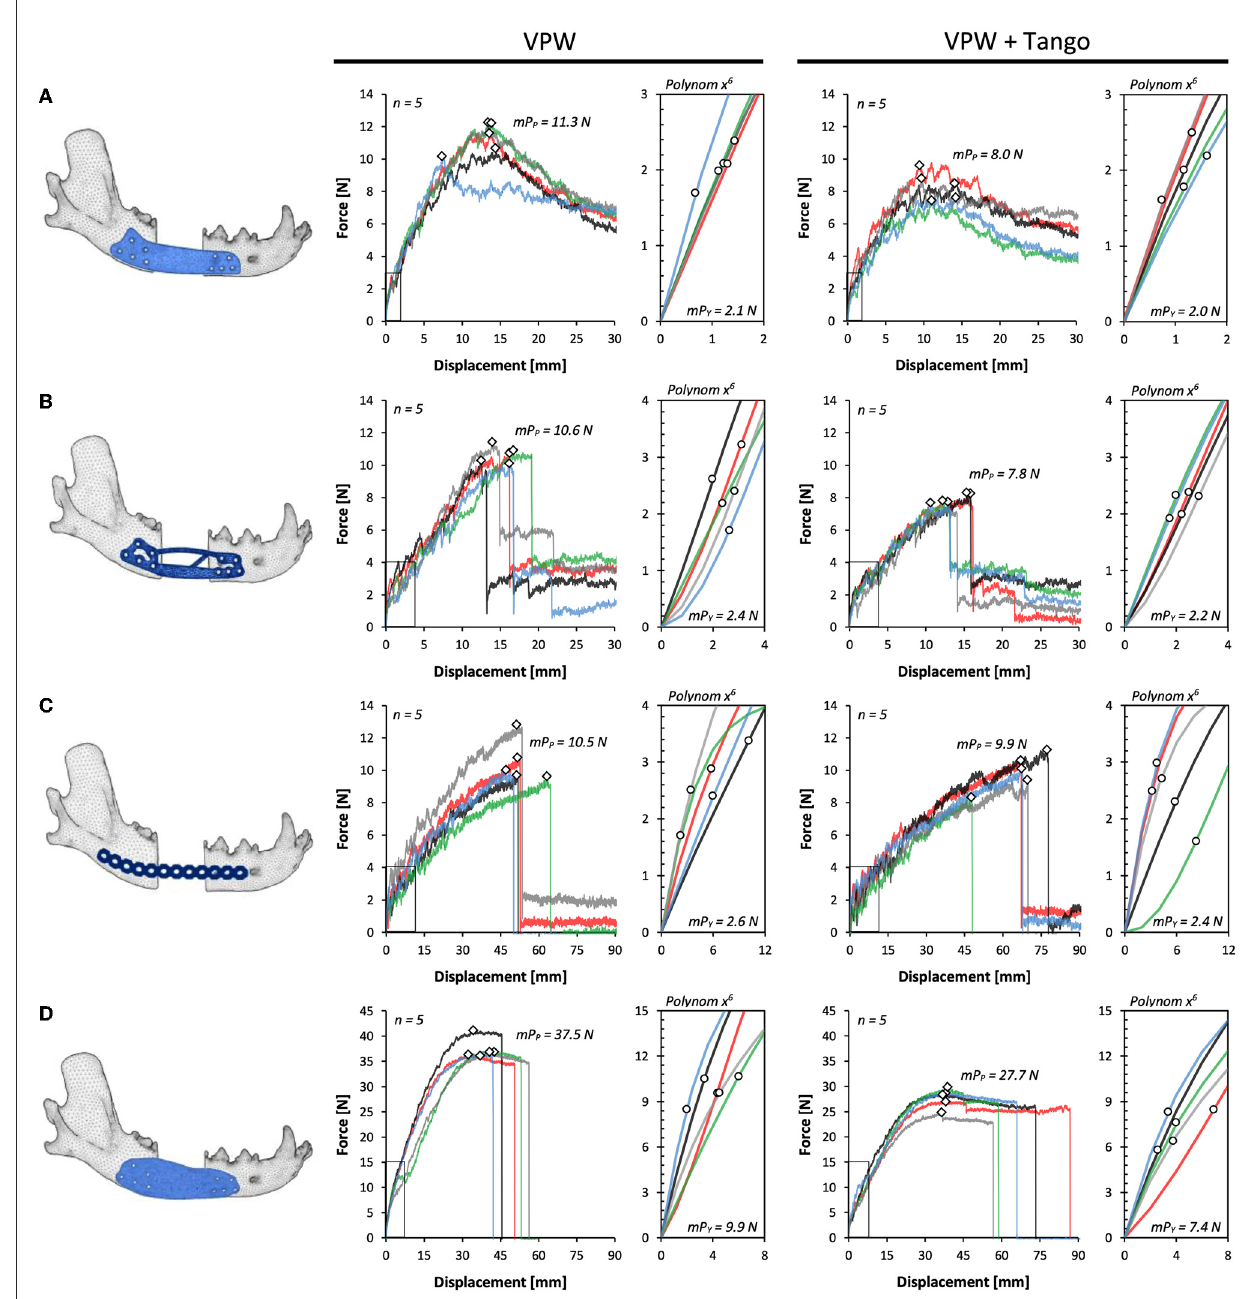
FIGURE4 Force-displacement curves for plate designs D1–4 (A–D) comparing rigid (VPW) and combination of rigid + rubbery (VPW + Tango) 3D printing materials. Yield points (circles) are shown in respective axis cutouts of start point linear variable interrelation; peak force/failure points are displayed as rhomb. mP p , mean peak force point; mP y , mean point of